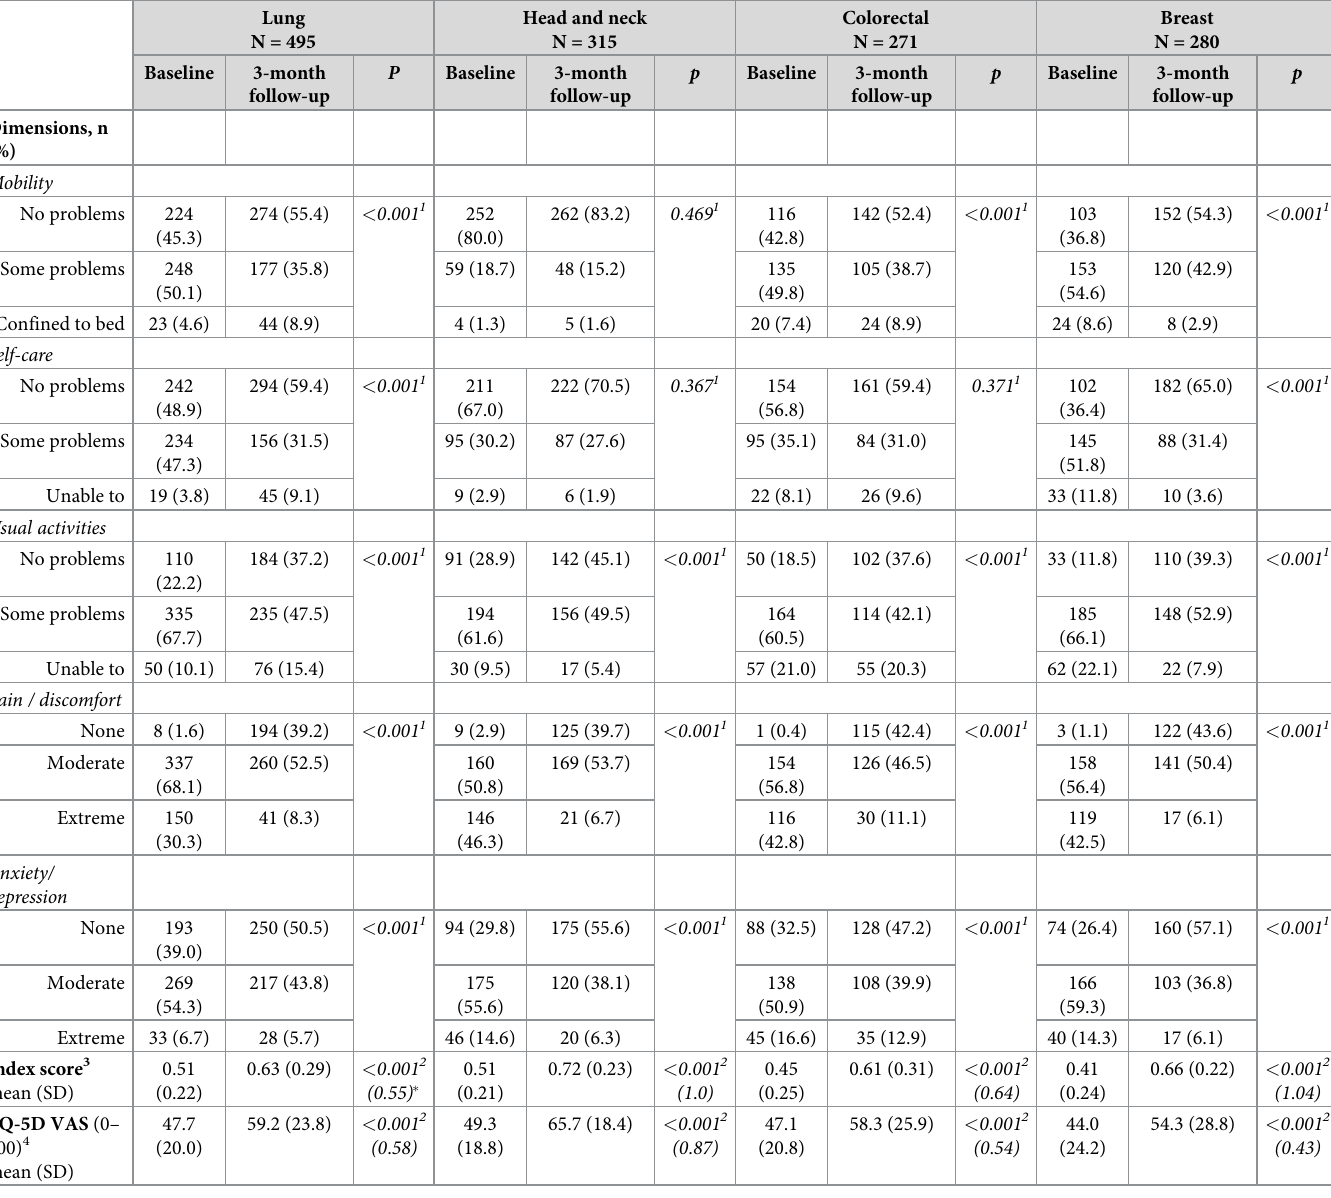
Table 3. Results of bivariate analysis showing changes in quality of life (EuroQoL-5D) by cancer type from baseline to 3-month follow-up